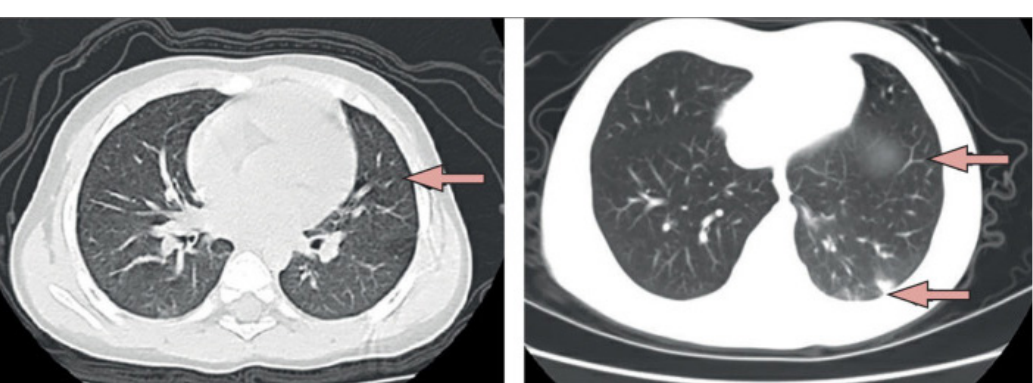
Fig. 1 – Chest computed tomography (CT) scans from two paediatric patients with coronavirus disease 2019[5]. Left: CT of 10-year-old boy showing multiple opacities in lower lobes of both lungs (arrow). Right: CT of 1.5-year-old girl showing multiple ground-glass opacities with a big patchy opacity in the right lung